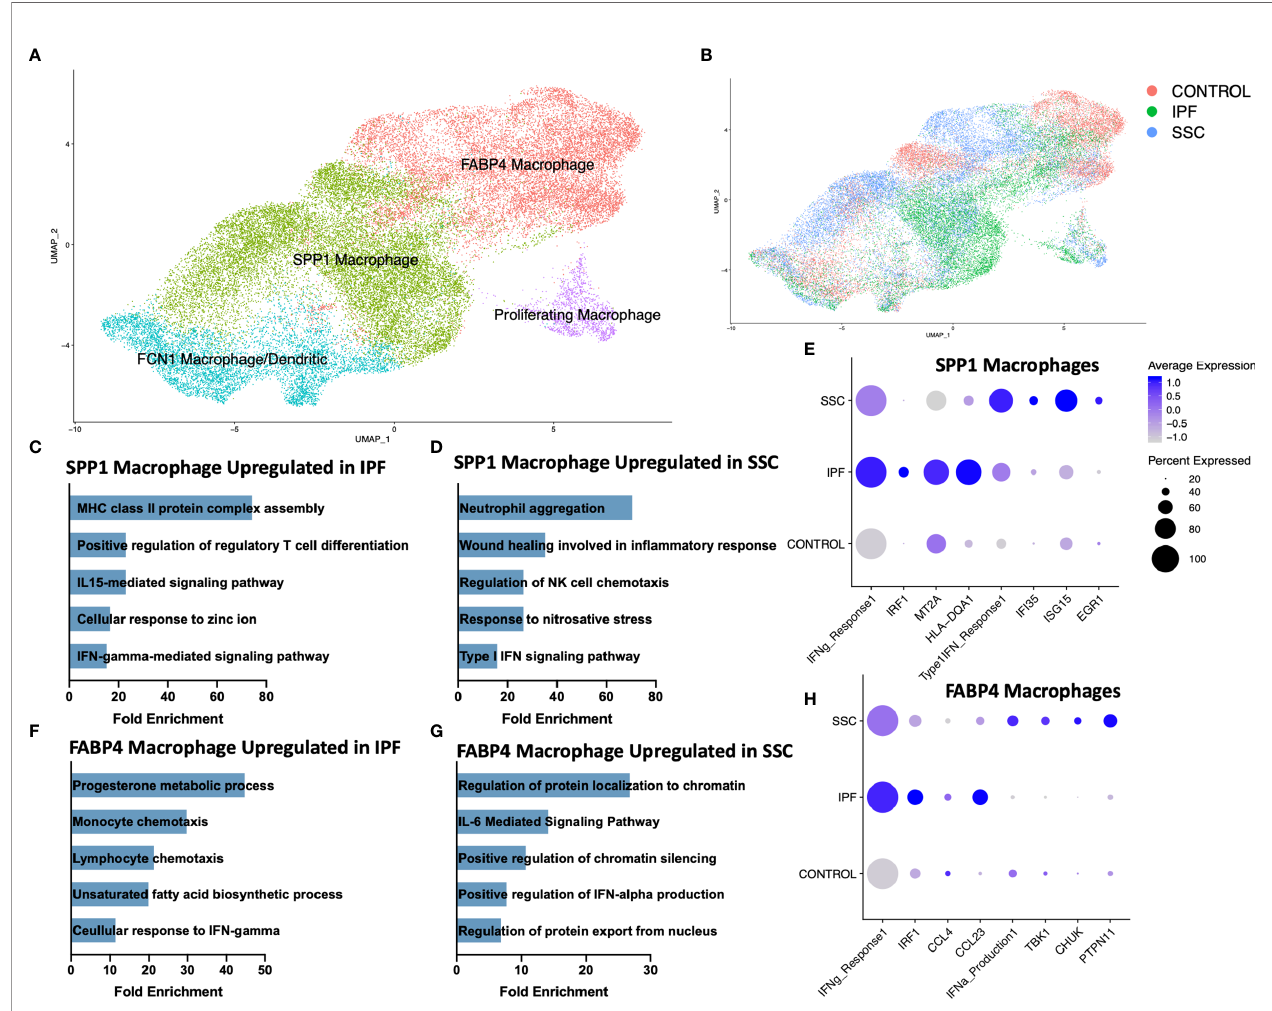
FIGURE 2 | ScRNA-seq analysis of IPF, SSc-ILD, and control myeloid populations. (A) UMAP plot of macrophage and dendritic cell populations, identi fi ed by cell type. (B) UMAP plot of macrophage and dendritic cell populations, identi fi ed by disease status. (C) Pathways upregulated in IPF SPP1 hi macrophages compared to SSc-ILD SPP1 hi macrophages (D) Pathways upregulated in SSc-ILD SPP1 hi macrophages compared to IPF SPP1 hi macrophages (E) Expression of selected genes and pathways in SPP1 hi macrophages, separated by disease state. Pathway expression depicted as a module score of all genes in the speci fi c GO biological process. (F) Pathways upregulated in IPF FABP4 hi macrophages compared to SSc-ILD FABP4 hi macrophages. (G) Pathways upregulated in SSc-ILD FABP4 hi macrophages compared to IPF FABP4 hi macrophages. (H) Expression of selected genes and pathways in FABP4 hi macrophages, separated by disease state. scRNA-seq, single-cell RNA-sequencing; IPF, idiopathic pulmonary fi brosis; SSc-ILD, systemic sclerosis-associated interstitial lung disease; UMAP, uniform manifold approximation and projection; GO, gene